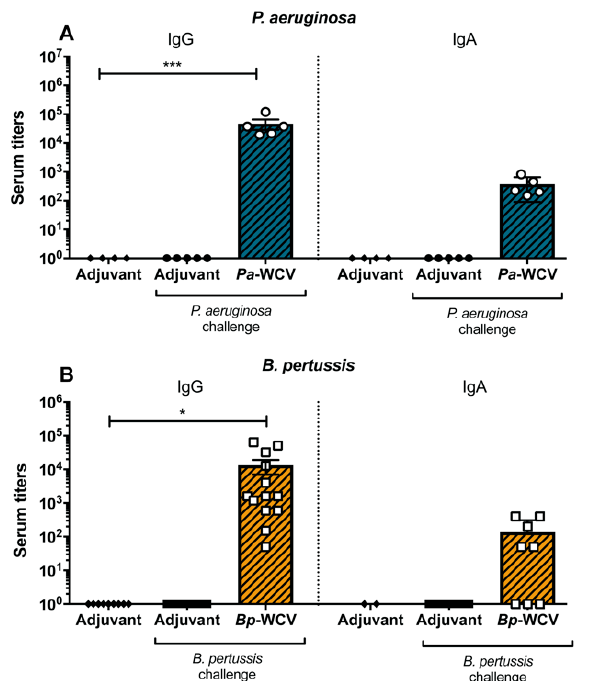
Figure 7. Vaccination induces pathogen specific antibody production. ( A ) Pa- WCV and ( B ) Bp- WCV serum IgG and IgA titers. ( n = 5–12 per group) The asterisks indicate statistical significance determined by ANOVA: * p ≤ 0.05, *** p ≤ 0.001.